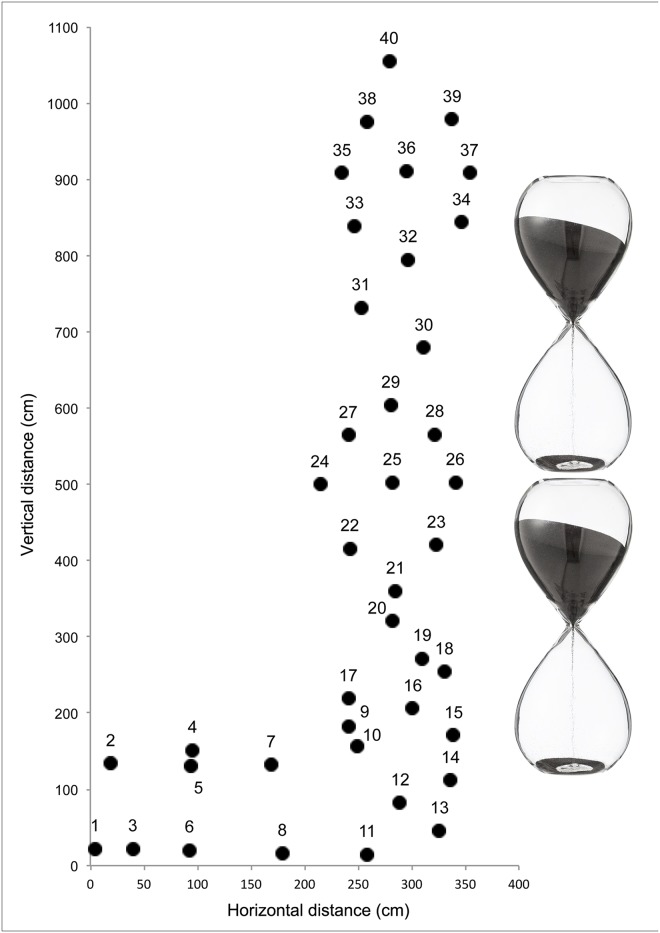
Map of the climbing route with the X and Y coordinates of the 40 holds.